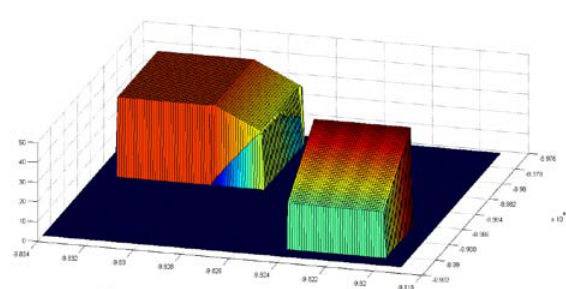
Figure 4: Shadow on the façade of the NW building casted from the SE building, coloured by